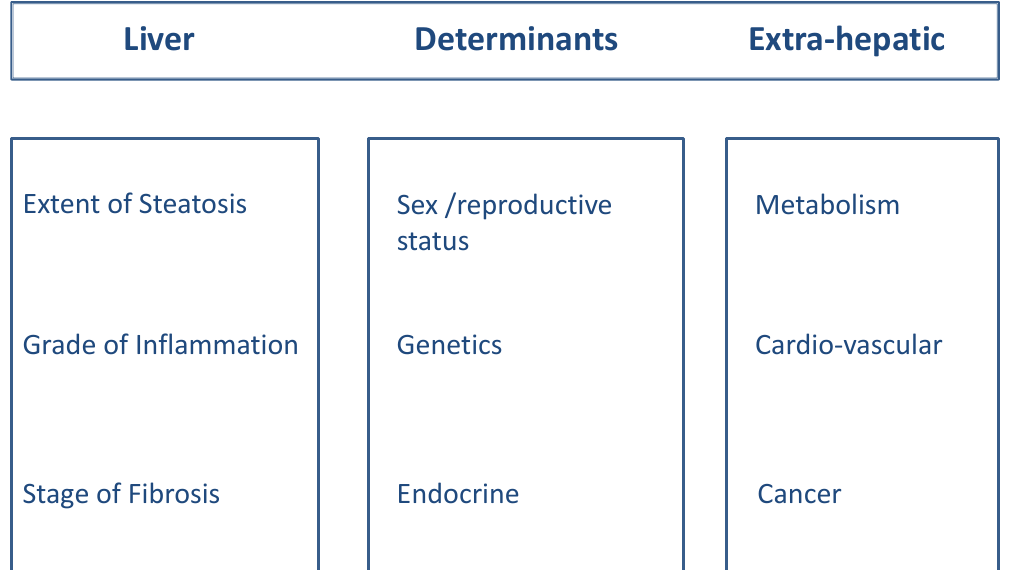
Figure 1. Articulating the taxonomy of MAFLD. The “LDE” system. Based on archaic suggestions [66] and earlier attempts [67], an international panel including eminent world authorities in NAFLD, none excluded, renamed NAFLD as metabolic associated fatty liver disease (MAFLD) [79]. This proposal now needs to be further articulated in order to fully explore the complexity of disease in the individual patient. The LDE system has a simple structure consisting of a prefix (L for liver), a central section (D for determinants) and a suffix (E for extra-hepatic); Liver (L) - We propose that MAFLD should include a prefix illustrating what, in the individual patient, is known about liver involvement. Information regarding this may be achieved, based on clinical judgement, either with non-invasive or biopsy evaluation [36]. Steatosis and inflammation may be classified into mild, moderate or severe and fibrosis as absent (F0), mild (F1-F2) ore advanced (F3-F4). Individuals who have overt cirrhosis and/or HCC should be declared so; Determinants (D) - The importance of sex and reproductive status cannot be overemphasized and genetic determinants, although not requested in all patients with NAFLD (reviewed in 49), must be acknowledged whenever data are available (Table 1). The